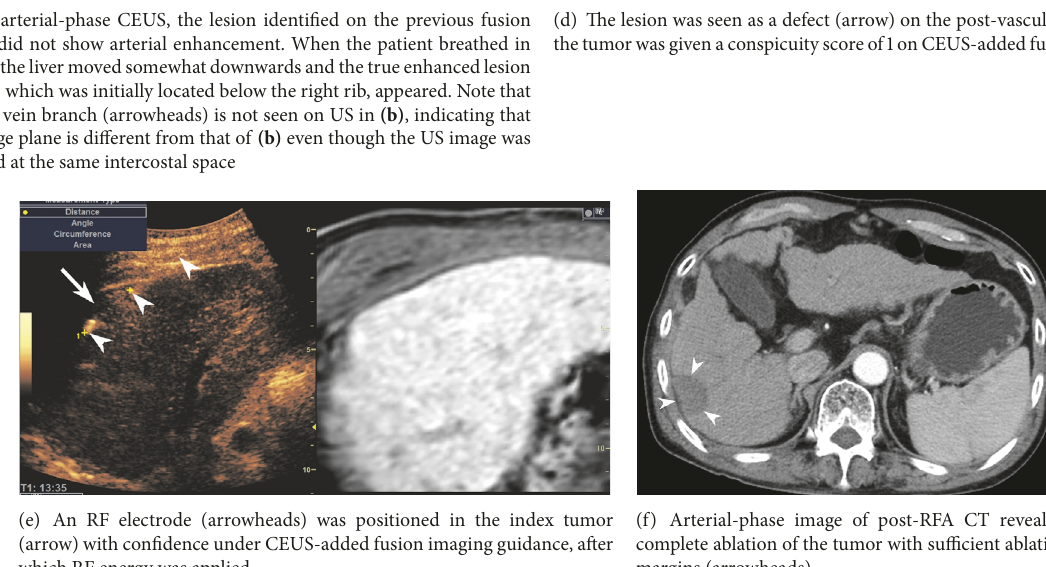
Figure 4: Images from a 65-year-old man with a recurrent HCC and hepatitis B virus-related liver cirrhosis who had previously undergone chemoembolization for